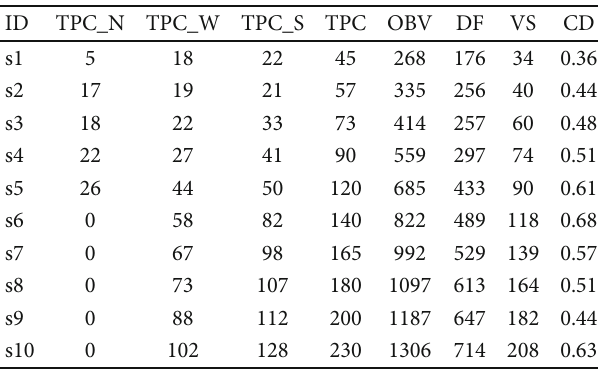
Table 2: Illustration of experiment scenario.